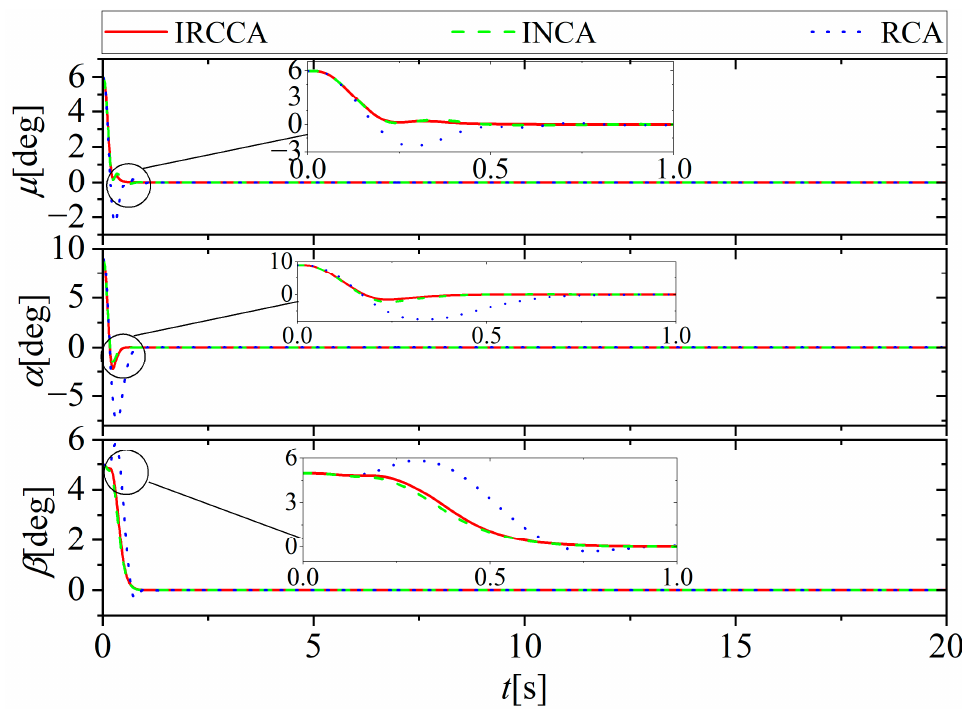
Figure 2. Time response of the attitude angle with no actuator fault.